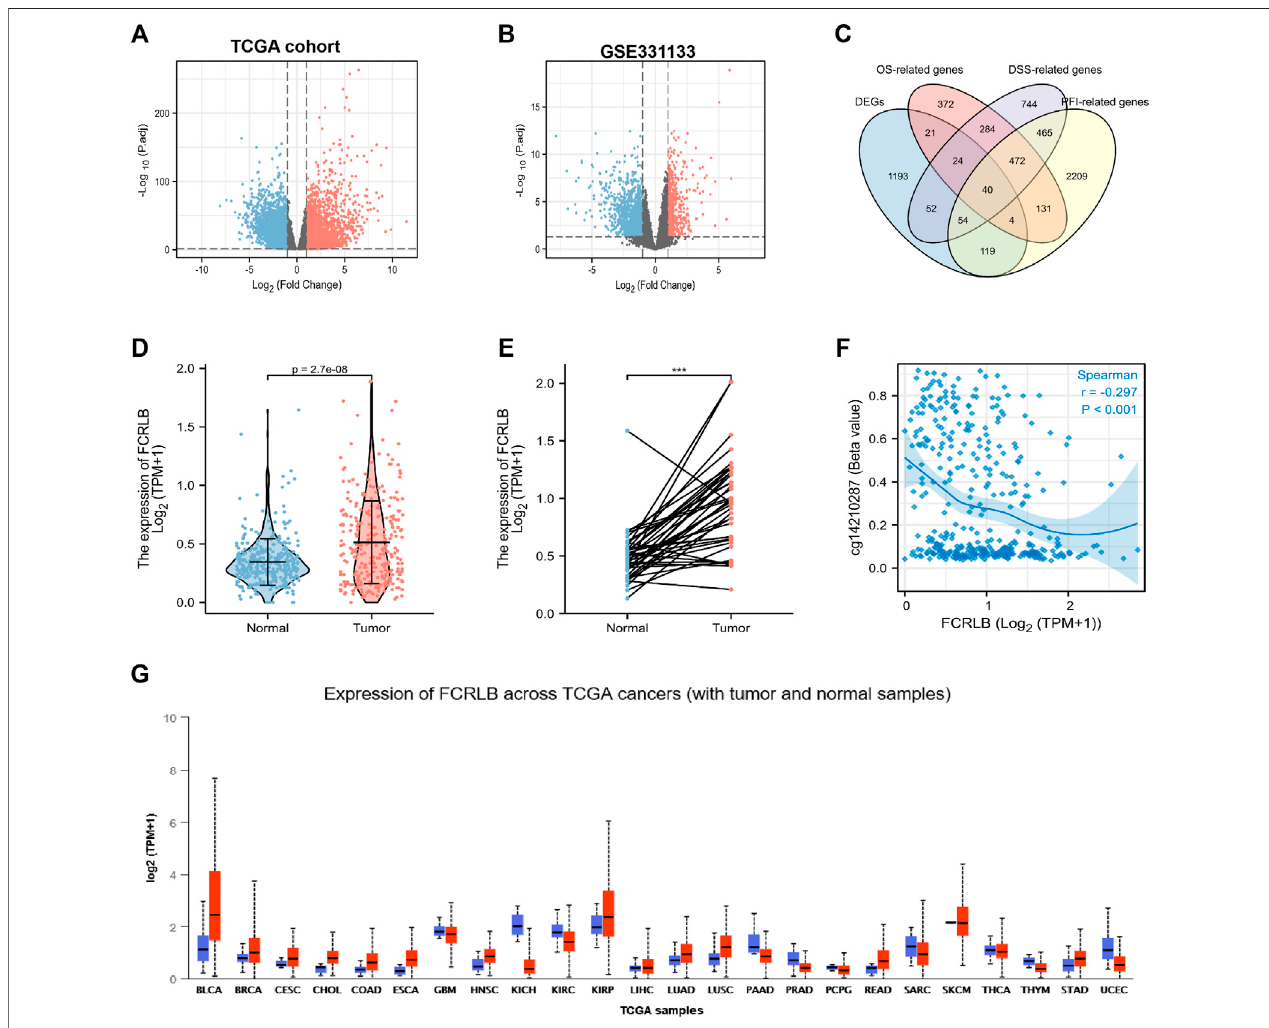
FIGURE 2 | FCRLB was highly expressed in CRC tissues and a variety of tumors. (A) The volcano plot showed the DEGs identi fi ed between the CRC and normal groups in TCGA cohort. (B) The volcano plot showed DEGs identi fi ed between CRC and normal groups in GEO database. The red and blue dot represents the up- regulatedgeneanddown-regulated genewithsigni fi cance,respectively. (C) Venndiagramshowinggenesscreenedbydifferentmethods. (D) Expressiondifferencesof FCRLB between 647 cancerous tissues and 51 non-tumorous tissues in the TCGA cohort. (E) Expression differences of FCRLB between 50 cancerous tissues and 50 matched adjacent normal tissues in the TCGA cohort. *** p < 0.001. (F) FCRLB expression was negatively correlated with promoter methylation (r = − 0.297, p < 0.001). (E) FCRLB was overexpressed in a variety of tumors in the TCGA cohort. (G) Expression level of FCRLB in pan-cancer.